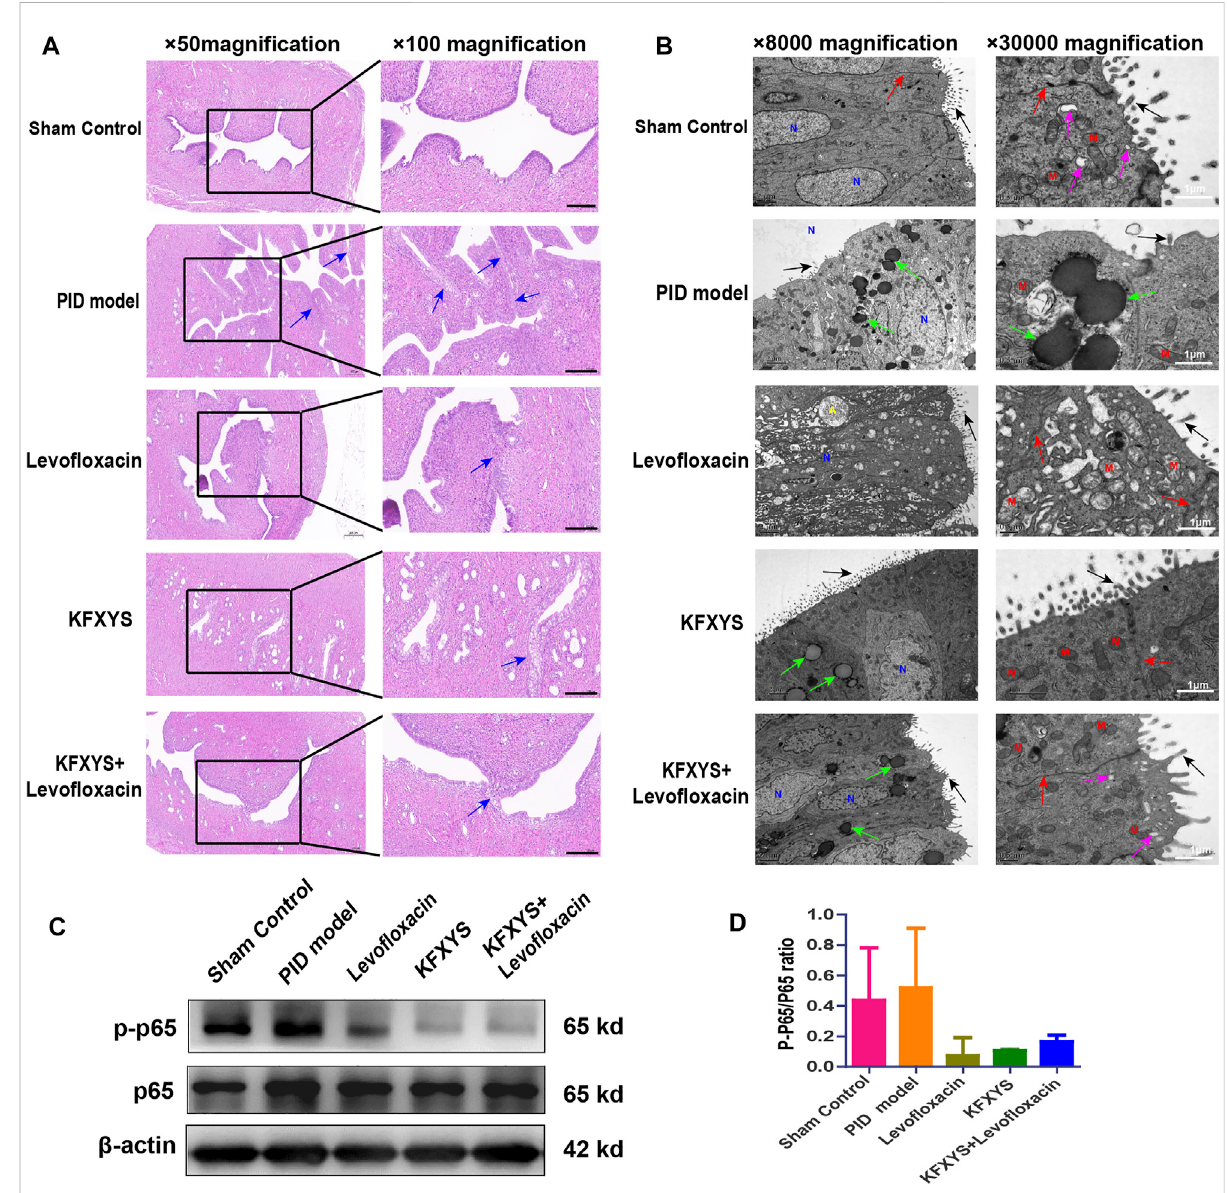
FIGURE 4 Histopathological and ultrastructural changes in uterine tissueafter 14 days of treatment and the expression of p65 and p-p65.(A) Uterine mucosaadhesionwasobservedbyHEstaining.Theblackarrowsindicatebandsofadhesivetissue.Imagesweretakenat50×or100×magni fi cation. Scale bar: 200 μ m. (B) Ultrastructural changes in the uterine mucosa of rats observed by TEM. Intact microvilli (black arrows), intercellular connections (red arrows), secretory vesicles (purple arrows), and lipid droplets (green arrows) were observed. N, nucleus; M, mitochondrion;